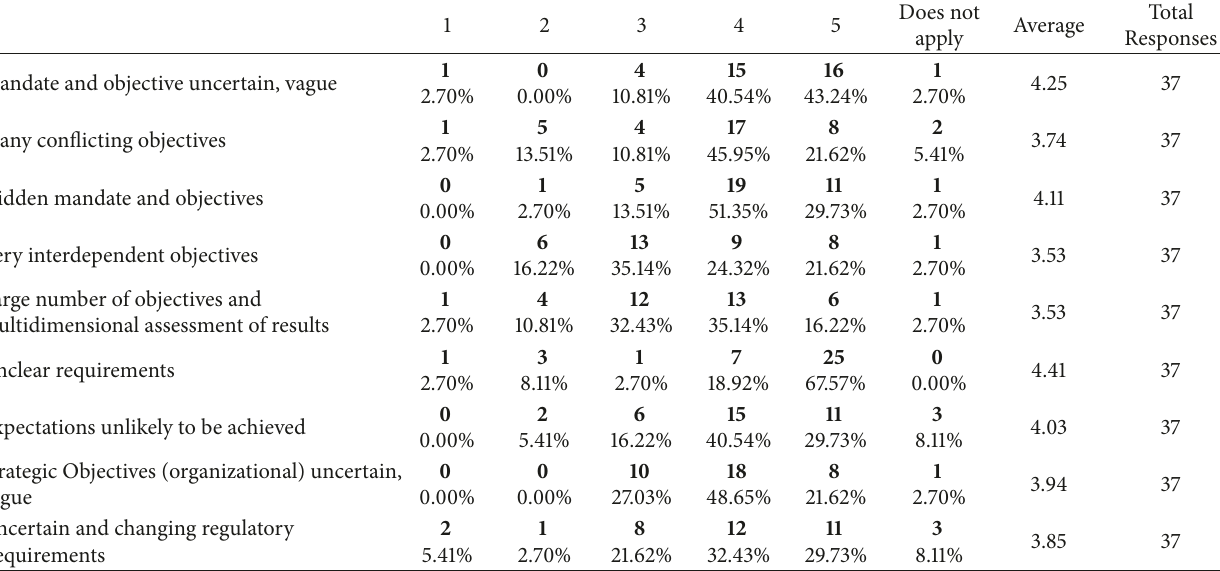
Table 4: Factors within Objectives, Requirements and Expectations , relative complexity ranking.